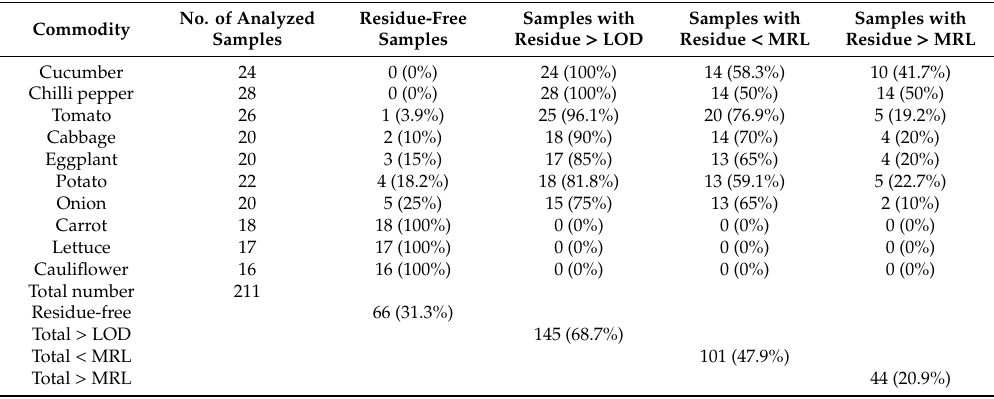
Table 2. Frequency of samples with pesticide residues in the Asir region, Saudi Arabia from